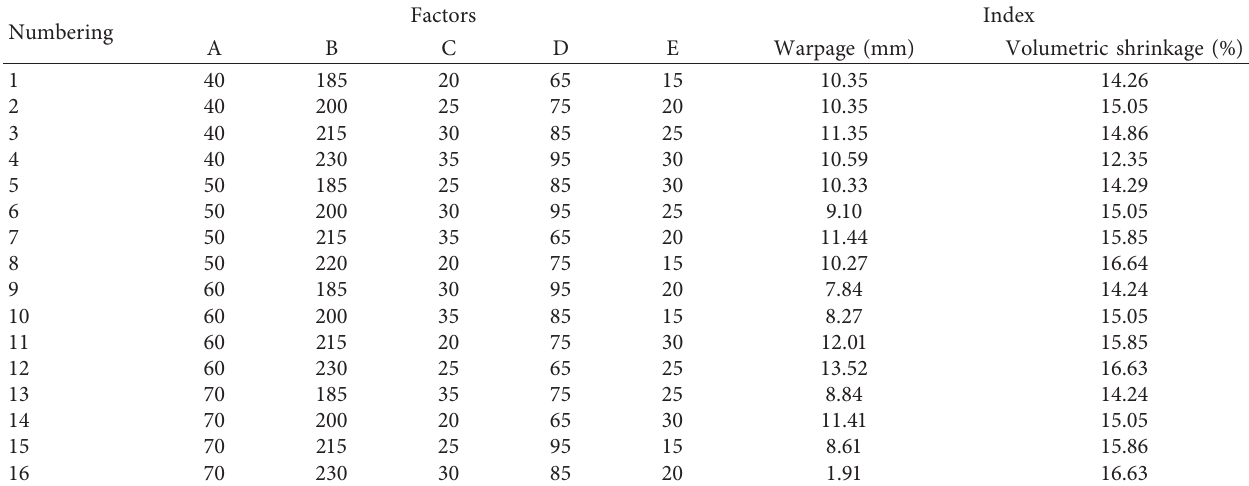
Table 6: Tests and results.